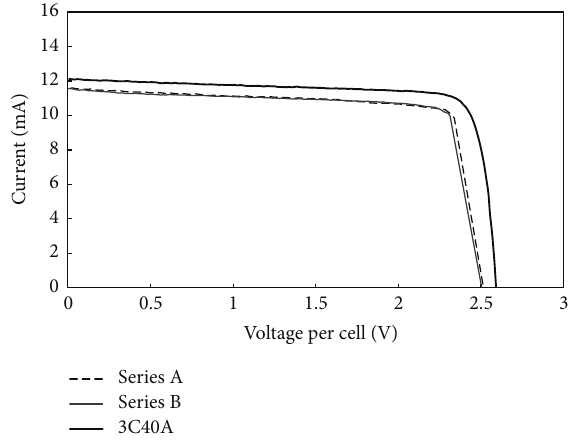
Figure 20: Comparison of the 𝐼𝑉 curves of one of the cells mounted on the large cell assembly and that of the 3C40A single-cell receiver produced by AZUR SPACE. The curves are measured in the same